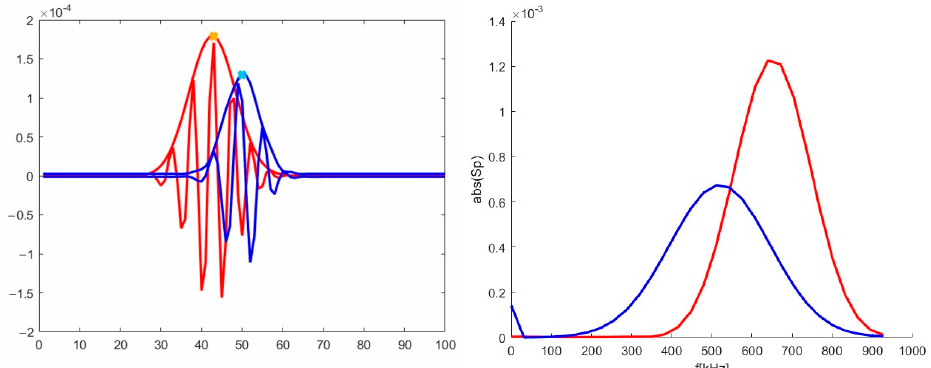
Figure 19. ( left ) DBS signals; ( right ) calculated spectra for the signal on the left. The blue lines correspond to the 39 GHz probing frequency, and the red line corresponds to 55 GHz.